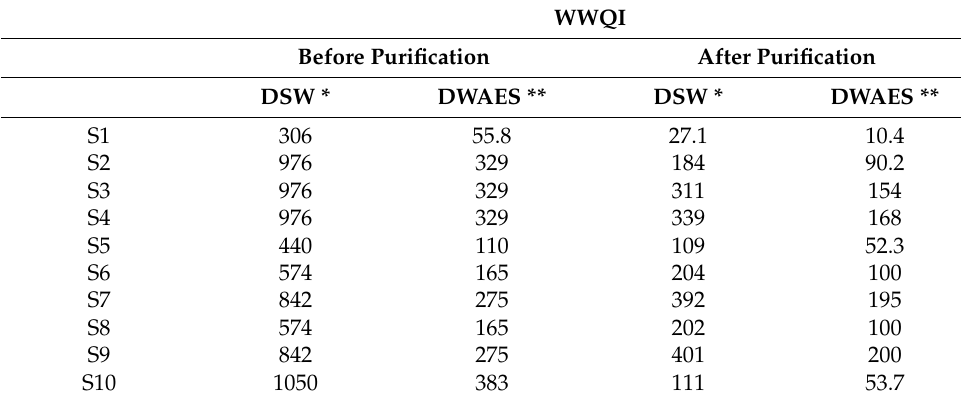
Table 4. Water quality index before and after zeolite purification .